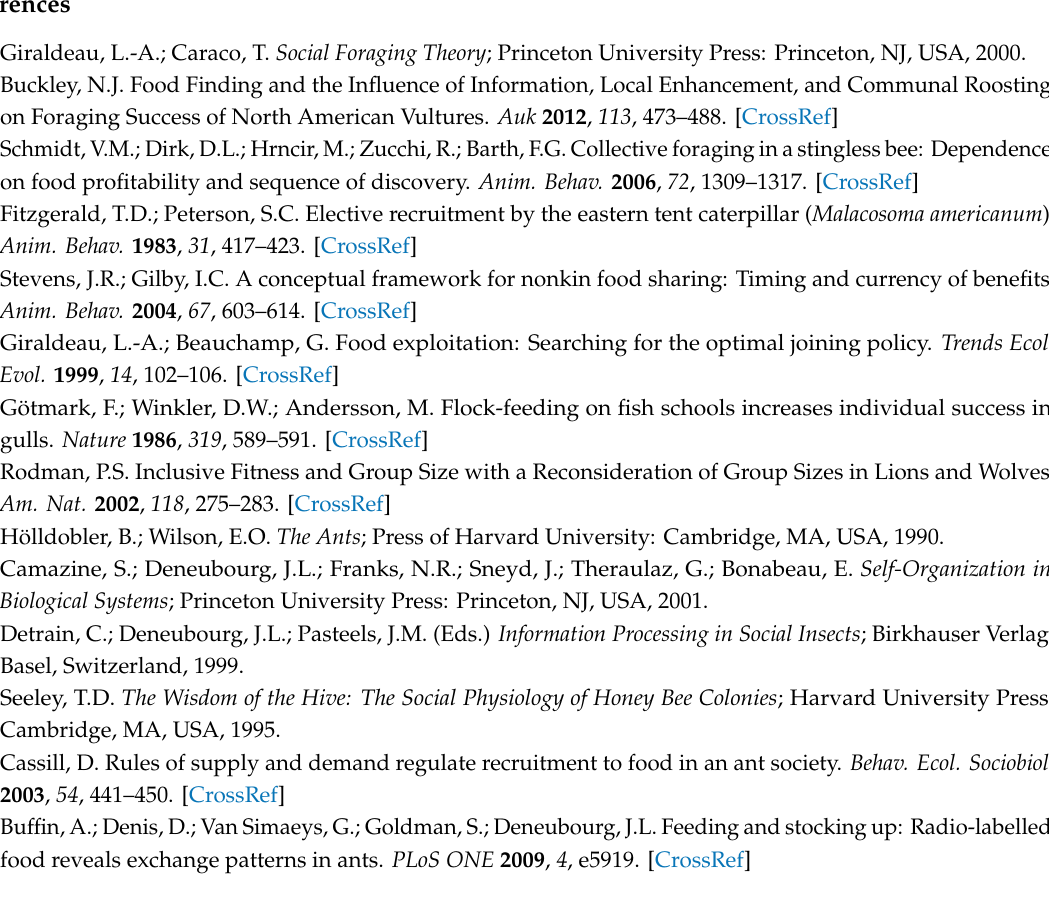
Figure S1: Spatial distribution of the entrances of Myrmica rubra colonies in 4m 2 quadrats, Figure S2: Monitoring of the flows of workers at each nest entrance, Figure S3: Influence of the number of entrances (A,C) and clusters (B,D) on the cumulated number of foragers observed at the feeders (A,B) and their distribution among the feeders quantified by the Pielou’s evenness Index (C,D), Figure S4: Influence of entrance proximity on the exploitation of a food source, Figure S5: Influence of the type of entrance clustering on the timing required to collect a unique food source of 600 units, Model: Description of the model developed to simulate the foraging activity of the ants, Table S1: Summary of observation sessions performed for each colony, Table S2: Summary of paint-marked ants per colony in the fidelity experiment, Data_and_code: data used for the figures and code used for the